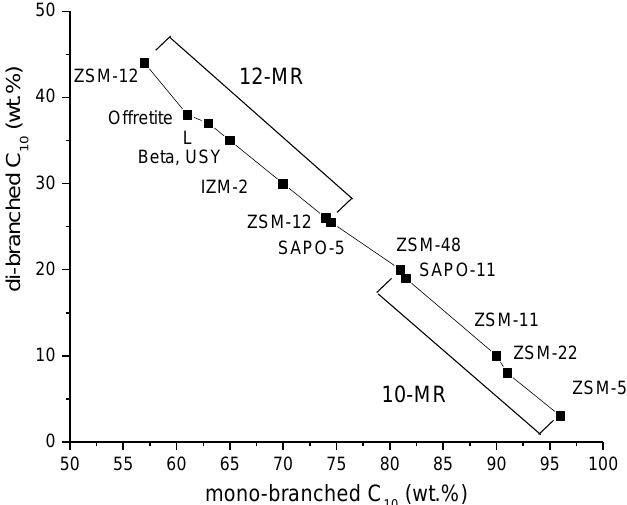
Figure 8. The yield of di-branched C10 as a function of monobranched C10 in n-decane hydro-isomerization at 5% isomerization yield. Conditions: 4.5 bar, 300 °C, H 2 /n-C10 molar ratio of 214, WHSV of 0.37 hr −1 [39]. Reproduced with permission from Mota et al., J. Catal. ; published by Elsevier, 2013 .